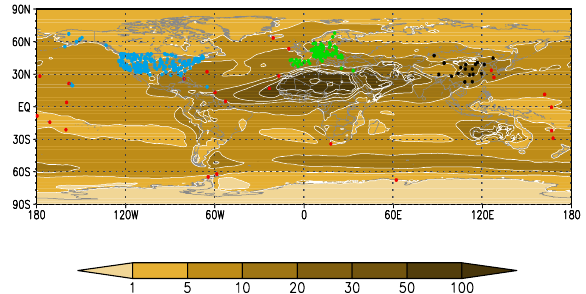
Fig. 2. Seasonality of sea salt aerosol mass production (mean±s.d.) at global scale and in the Northern (NH) and Southern Hemisphere (SH) oceans (1 Pg = 10 12